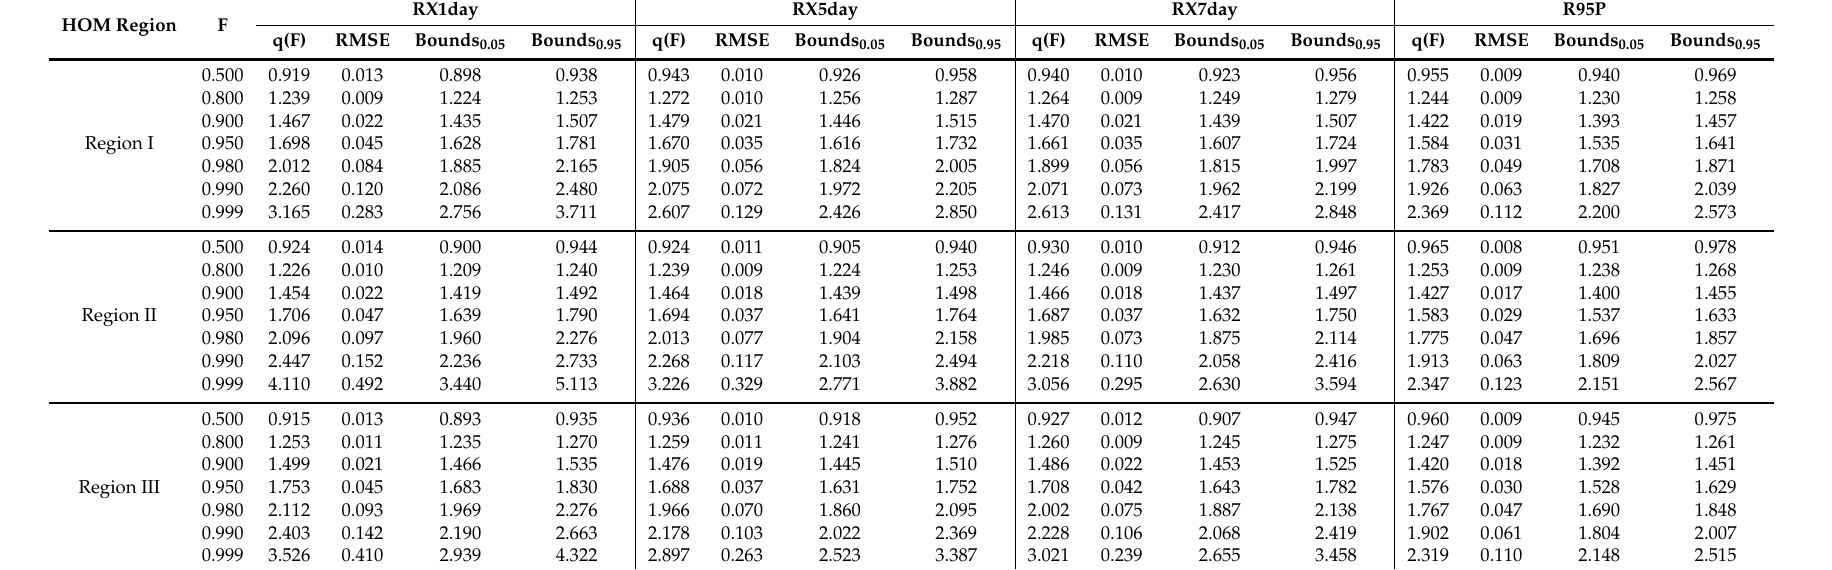
Table 4. Accuracy measures for estimated growth curve of the HJRB precipitation